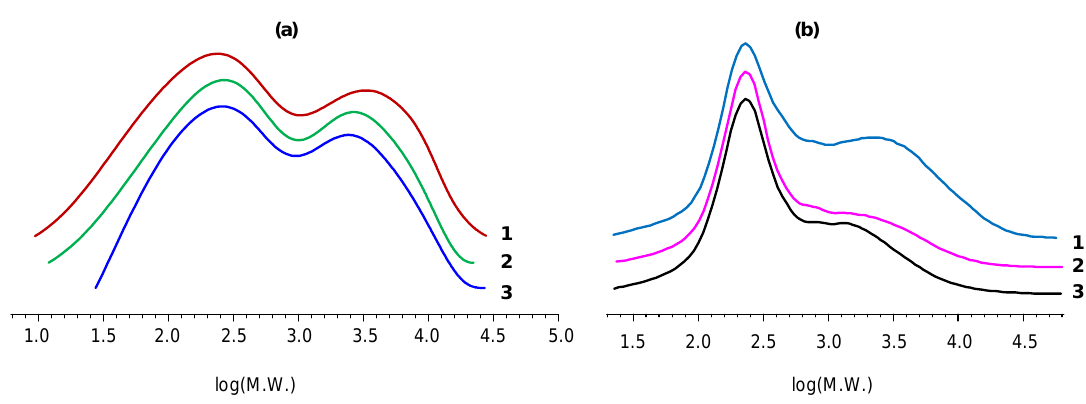
Figure 8. Gel-permeation chromatograms of PEO obtained in this by scheme A ( a ) with molar ratio of HCP:phenol:bisphenol A = 1:2:6 (1), 1:4:4 (2), 1:3:5 (3); and of resorcinol-based PEO ( b ) obtained in previous work [57] by interaction of HCP with resorcinol with molar ratio of HCP:resorcinol = 1:12 (1), 1:16 (2) and 1:24 (normalized to the height of the main peak).